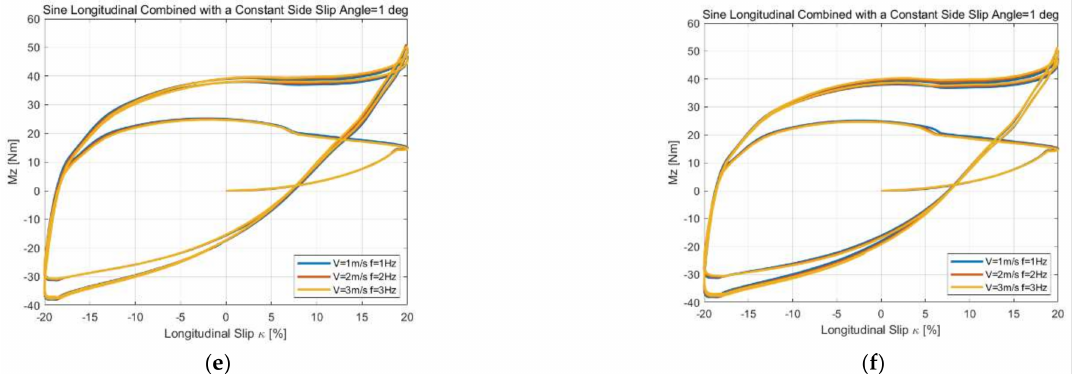
Figure 16. Response of lateral force and aligning moment under sine longitudinal combined with a constant side slip. ( a ) Response of longitudinal force using the proposed method. ( b ) Response of longitudinal force using the reference method. ( c ) Response of lateral force using the proposed method. ( d ) Response of lateral force using the reference method. ( e ) Response of aligning moment using the proposed method. ( f ) Response of aligning moment using the reference method.